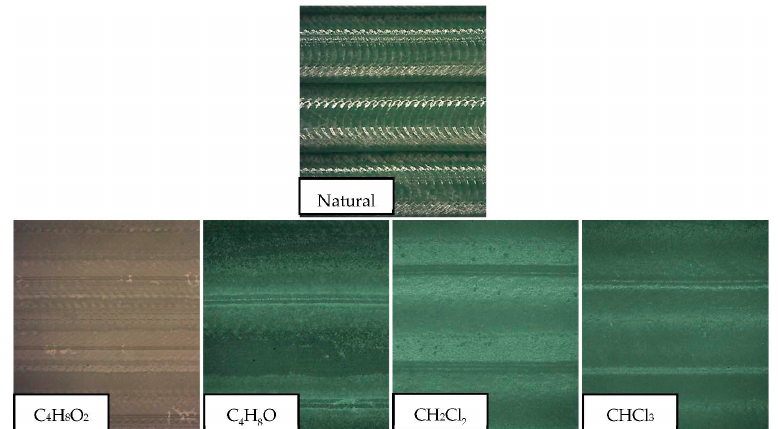
Figure 5. Surface smoothing after immersion in solvents.